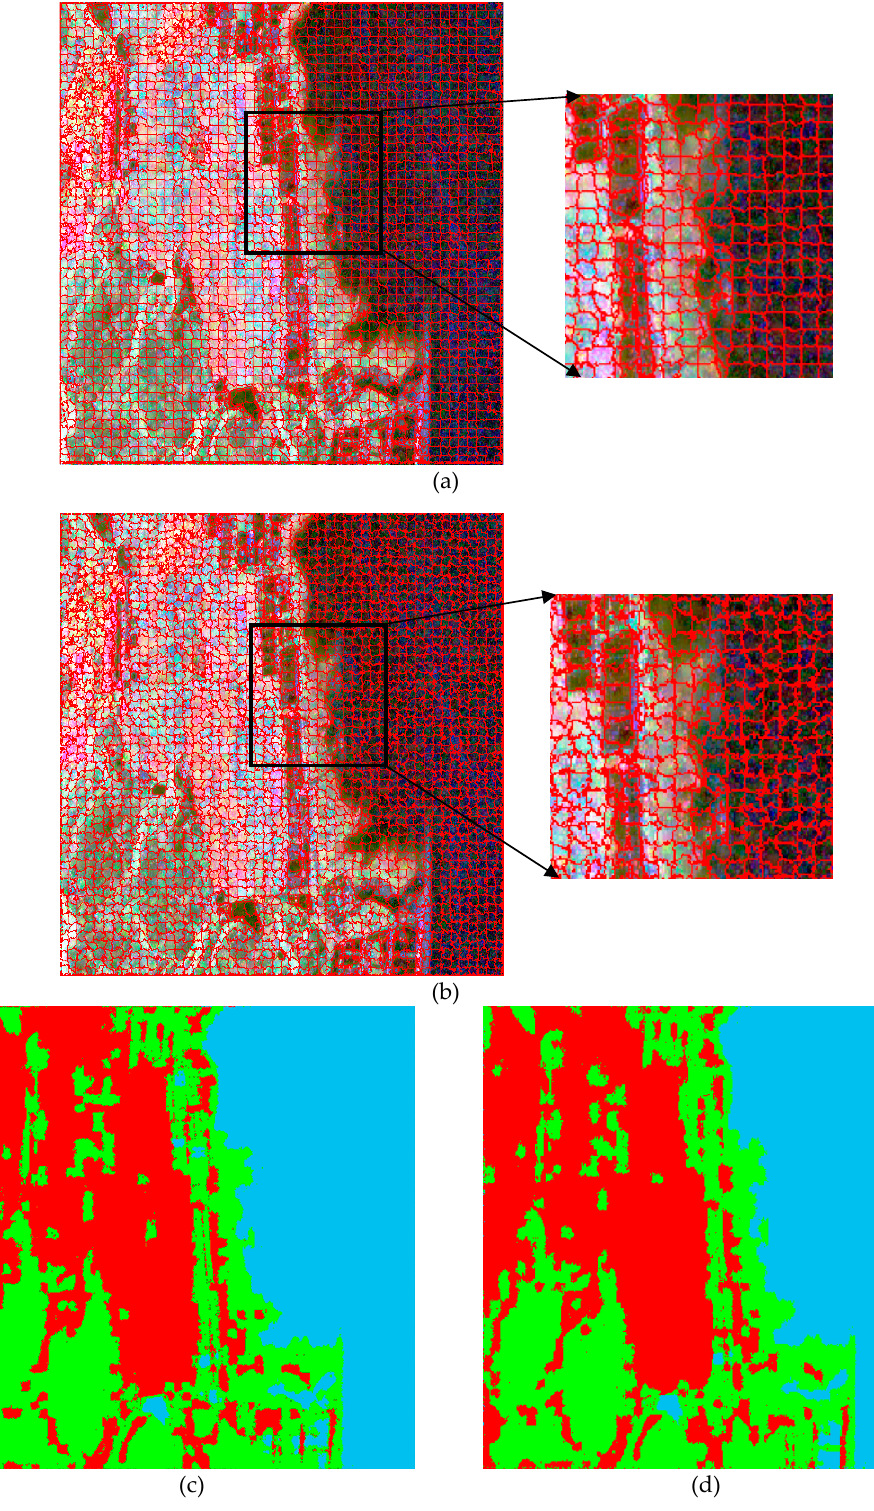
Figure 10. Region-based segmentation and classification results of the Fujian dataset. ( a )-( b ) Segmentation results of the whole image. ( a ) WMRF. ( b ) KMRF ( c ) Classification result with WMRF. ( d ) Classification result with KMRF.